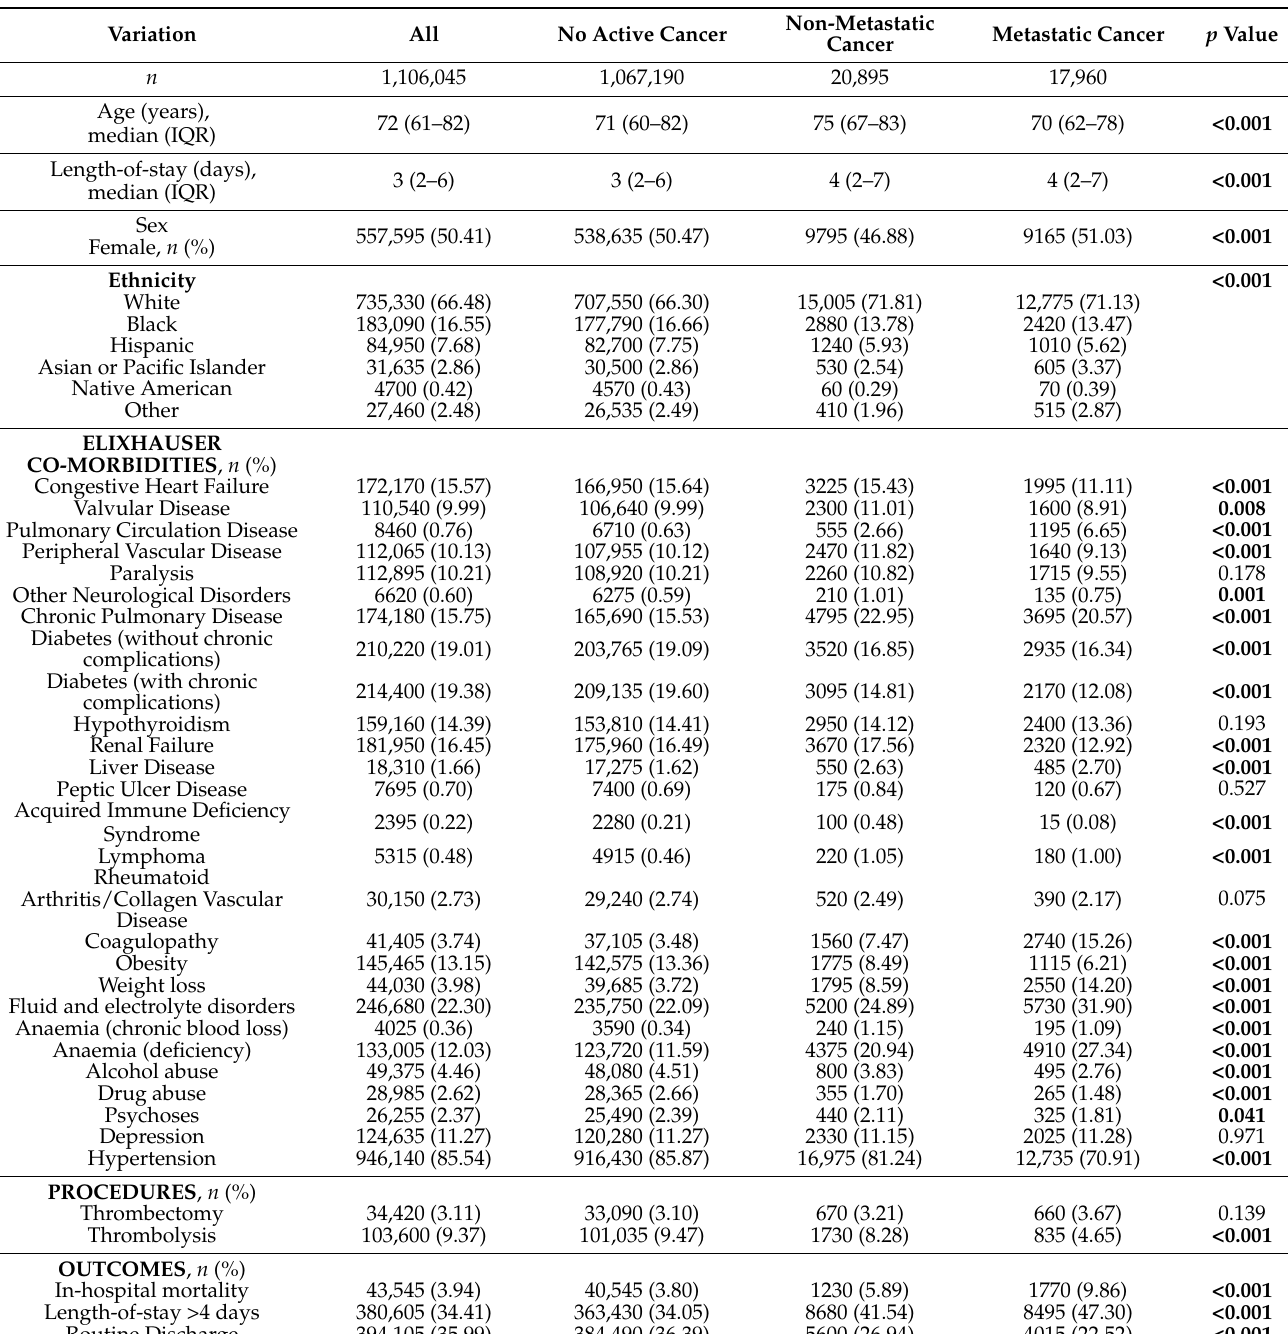
Table 1. Patient characteristics on admission, stratified by either co-existent non-metastatic or metastatic cancer. Further descriptive statistics are detailed in Table S3. Statistically significant p values (<0.05) are highlighted in bold .